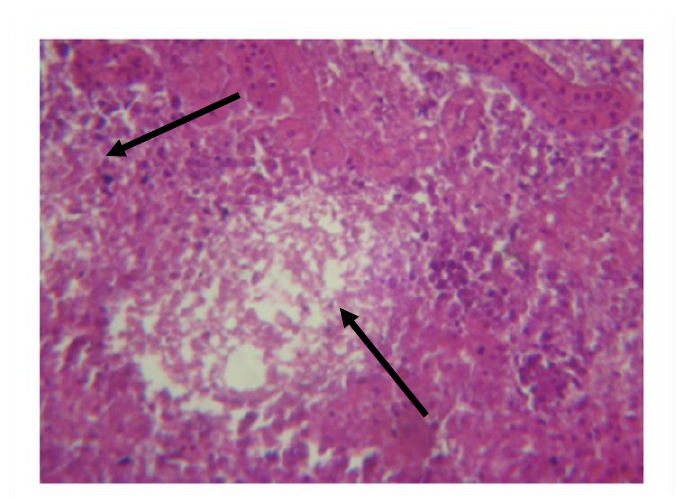
Figure4: Histopathological section of kidney 14day post infection show severe tubules necrosis with focal area of necrosis associated with intense inflammatory reaction